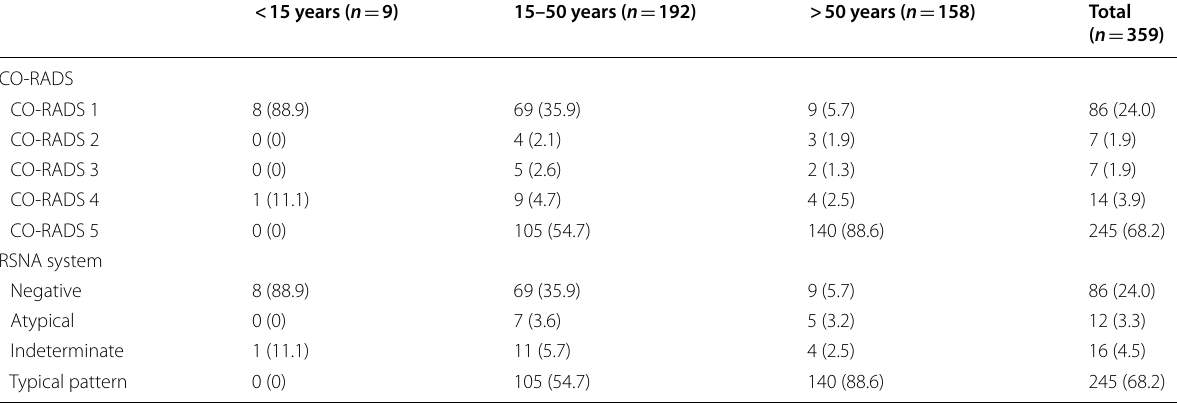
Date represent the number of patients and percentage in parenthesis n number, CO-RADS COVID‑19 Reporting and Data System, RSNA radiological Society of North America, CT computed tomography, COVID-19 coronavirus disease